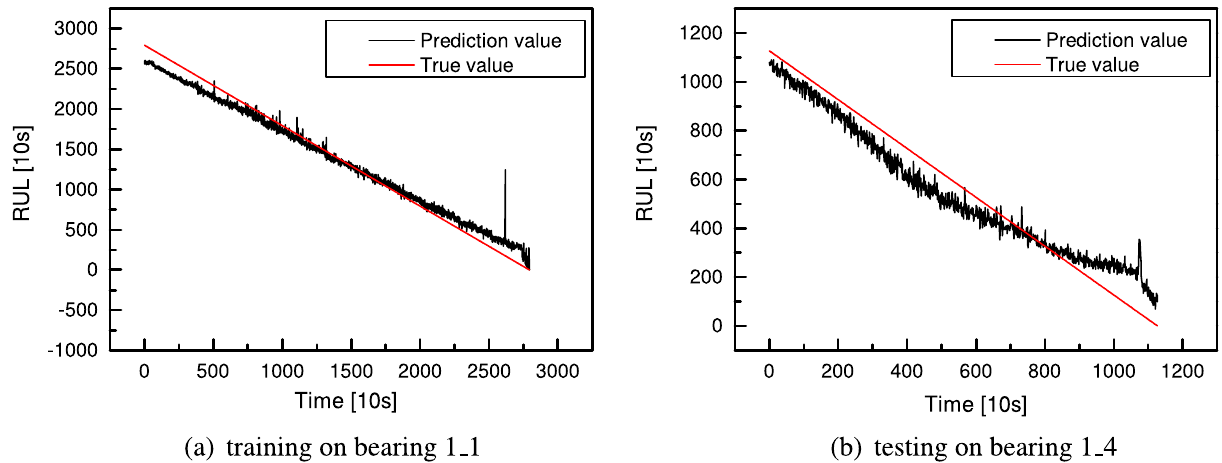
Figure 19. RUL prediction for training bearing 1_1 ( a ) and testing bearing 1_4 ( b ) using CNN with four